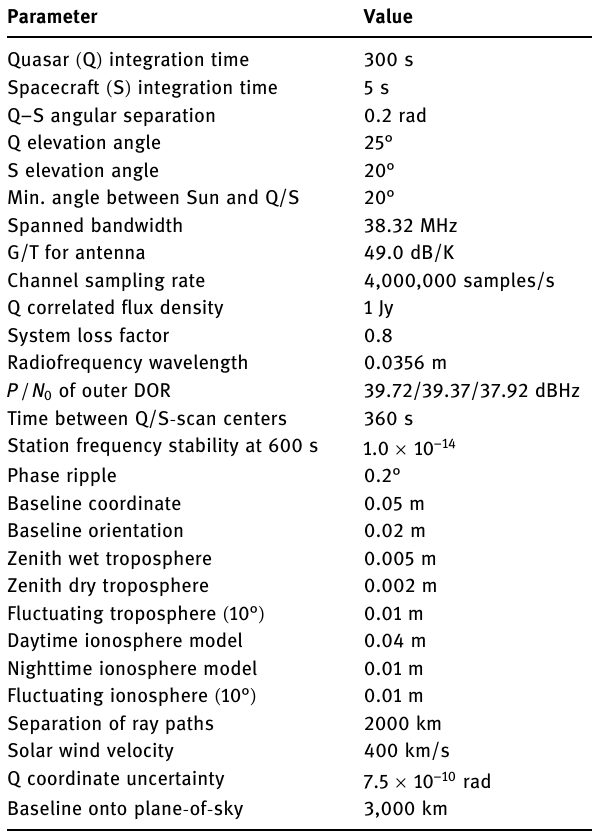
Table 2: Key performance outcomes of the classic, normal, and novel designs in the case of Tianwen - 1 Term